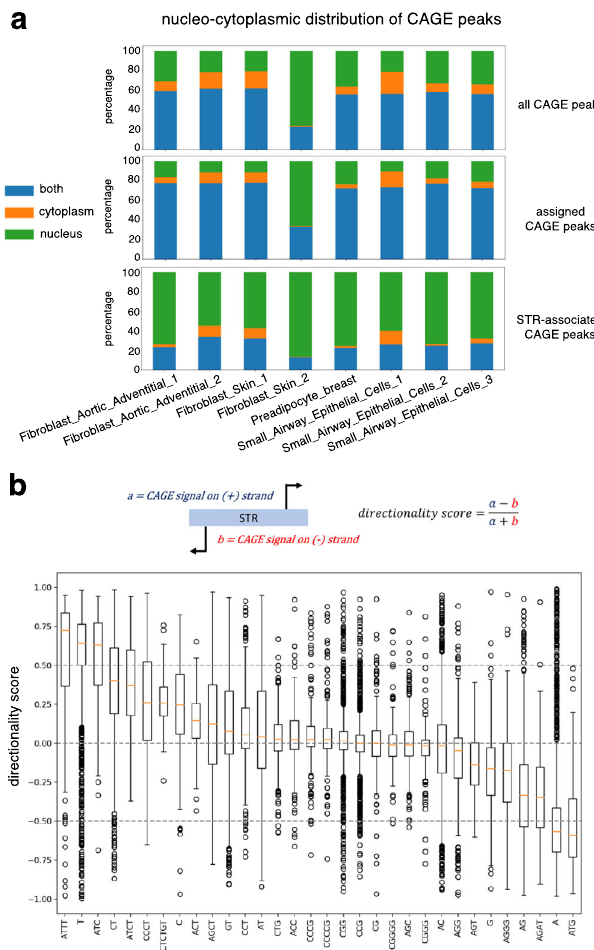
Fig. 4 CAGE peaks at STRs exhibit speci fi c features. a STR-associated CAGE tags are preferentially detected in the nuclear compartment. For each indicated library ( x axis) and each CAGE peak, CAGE expression (TPM) was measured in nuclear and cytoplasmic fractions. Each CAGE peak was then assigned to the nucleus (if only detected in the nucleus), cytoplasm (if only detected in the cytoplasm), or both compartments (if detected in both compartments). The number of CAGE peaks in each class is shown for each sample as a fraction of all detected CAGE peaks. The sample Fibroblast_Skin_2 likely represents a technical artifact. Analyses were conducted considering 201,802 FANTOM5 CAGE peaks (top), 54,001 CAGE peaks assigned to genes (middle), and 14,509 CAGE peaks associated with STRs (bottom). b Boxplots of directionality scores for each STR class with >100 elements. A score of 0 means that the transcription is bidirectional and occurs on both strands. A score of 1 indicates that transcription occurs on the ( + ) strand, while − 1 indicates transcription exclusively on the ( − ) strand (STRs being de fi ned on the ( + ) strand in HipSTR catalog). Boxplots are de fi ned as in Fig.